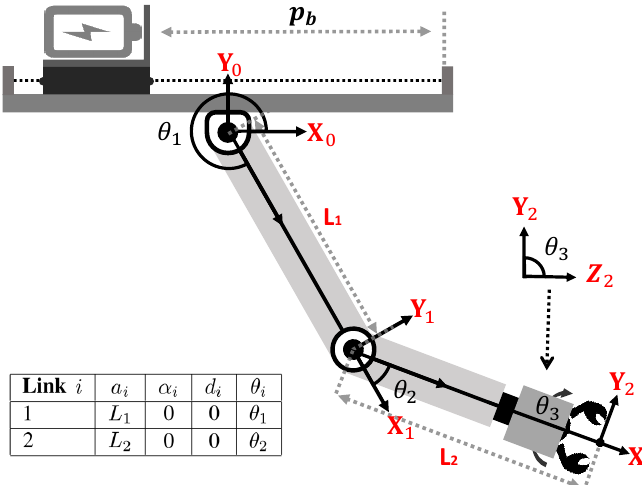
Figure 2. The coordinate system and Denavit–Hartenberg (D–H) parameters of the robotic